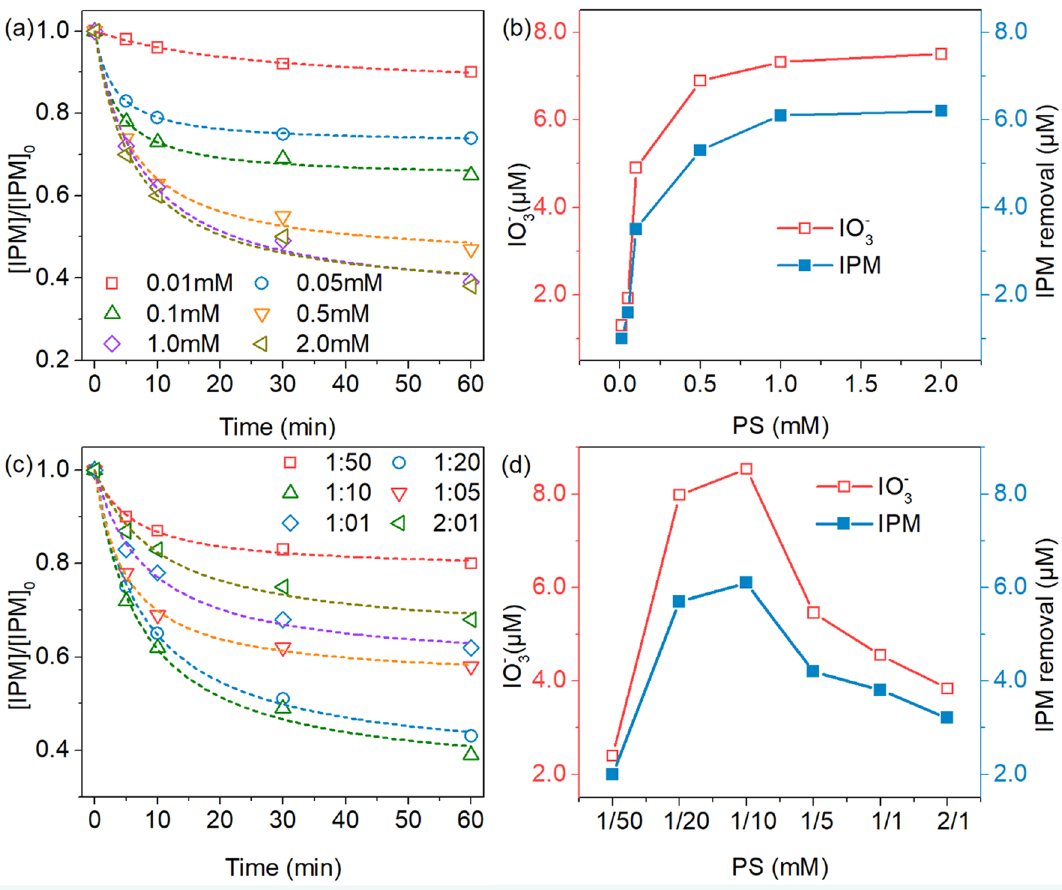
Figure 2. ( a ) Effect of PS concentration on IPM degradation efficiency, ( b ) the iodine amount that was removed, under an experimental condition of initial IPM concentration of 10 μM, a initial pH value of 3.0, at 25 °C and a Fe(II)/PS of 1:10, ( c ) Effect of Fe(II)/PS mole ratio on IPM degradation efficiency and ( d ) the iodine amount that was removed, under an experiment condition of a initial IPM concentration of 10 μM, a initial pH value of 3.0, at 25 °C and a PS concentration of 1